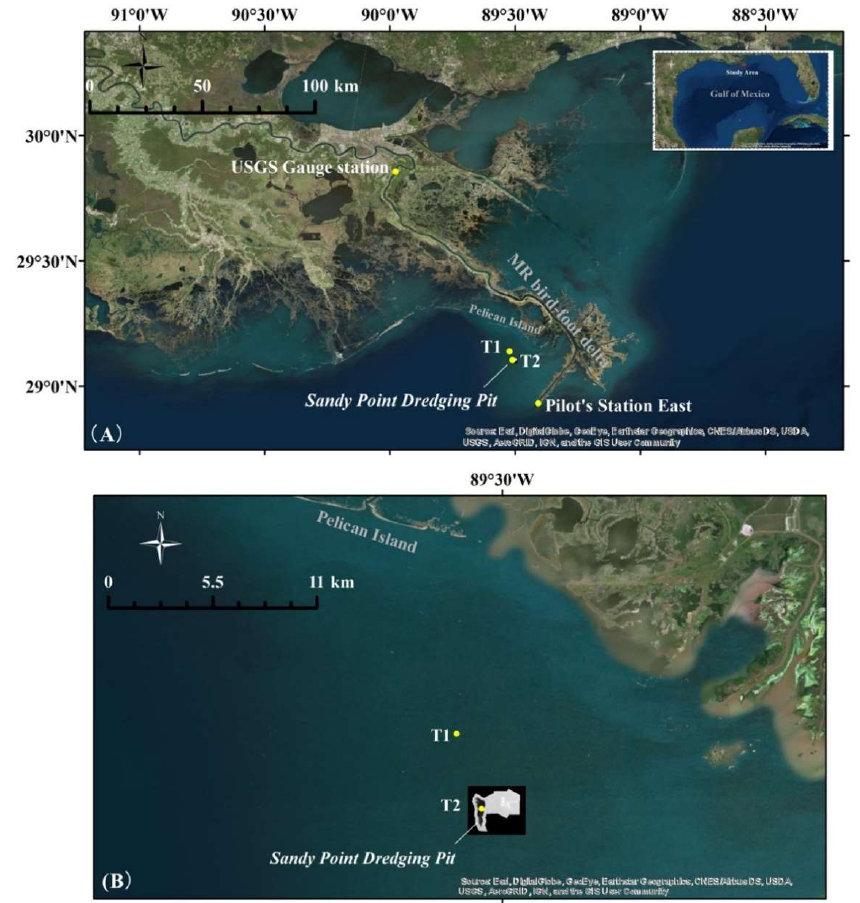
Figure 1. ( A ) Locations of Sandy Point dredge pit, observation sites T1 (north) and T2